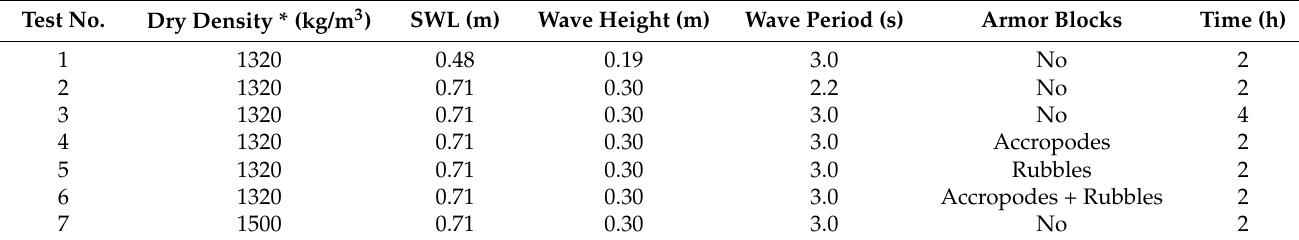
Table 3. Test conditions considering the wave parameters and the wave energy dissipation measure. Test